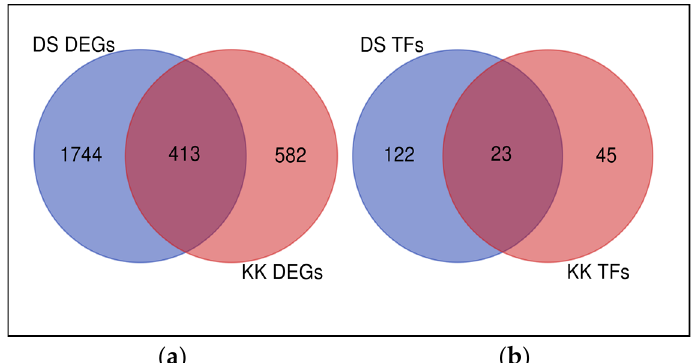
Figure 2. Venn diagrams showing DEGs common or specific to the two pepper cultivars. ( a ) Number of total DEGs, ( b ) number of DE TFs (PlantRegMap/PlantTFDB v5.0). The DEGs were identified in response to PSTVd infection at 43 dpi.